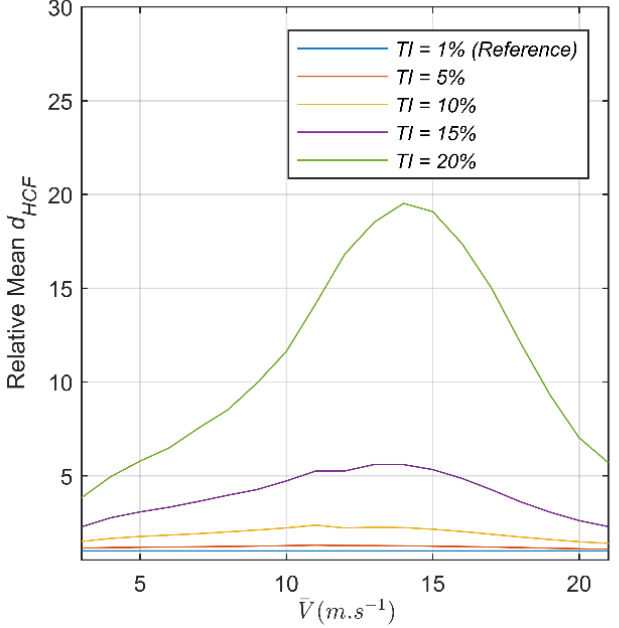
Figure 11. Relative mean WTB damage d HCF regarding a generated 1 Hz wind speed signal for a 10-min period as a function of the V for different TI , taking the mean d HCF for TI = 1% as reference.